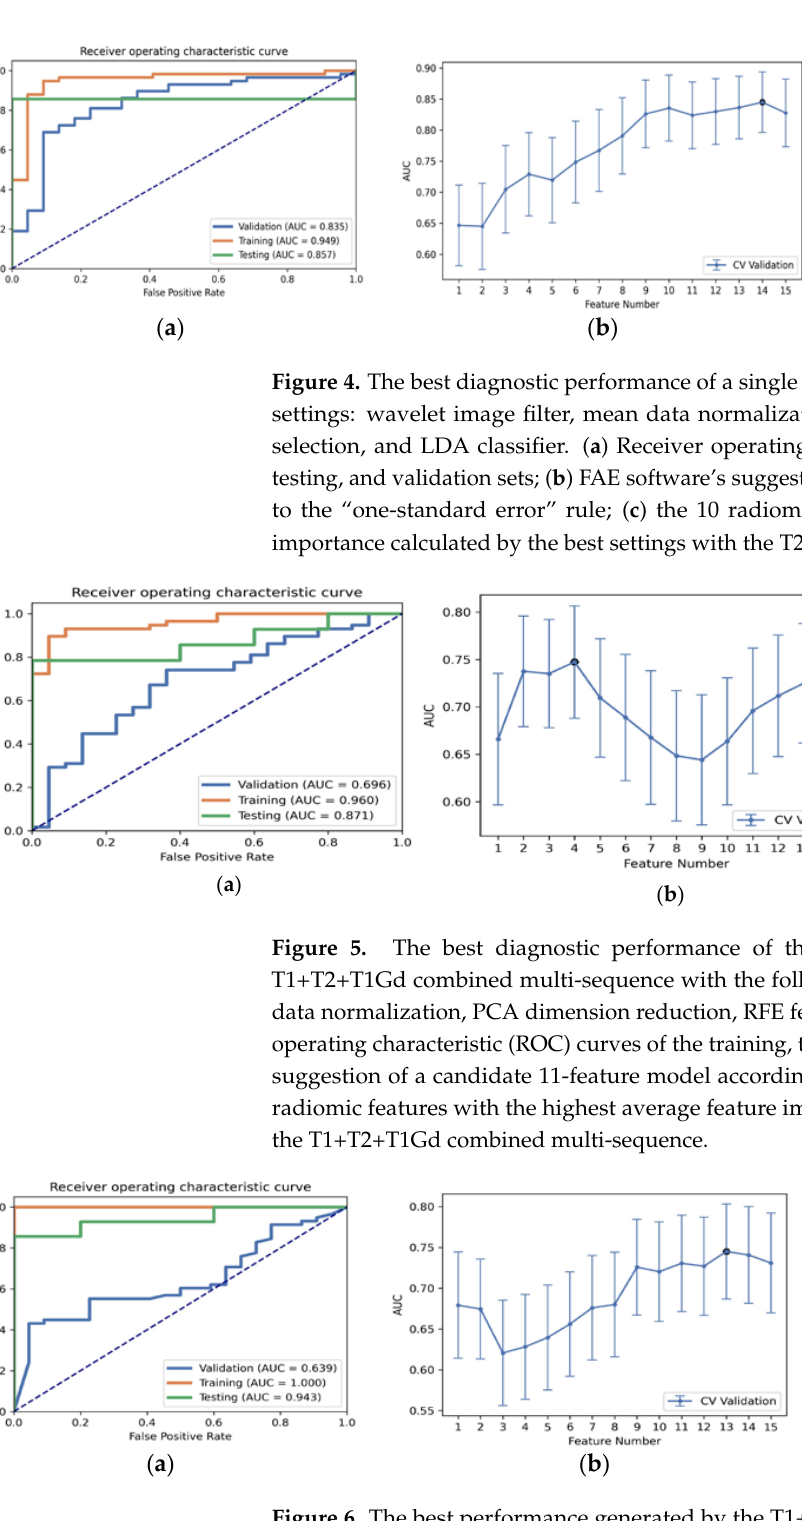
ware’s suggestion of a candidate 14-feature model according to the “one-standard error” rule; ( c )